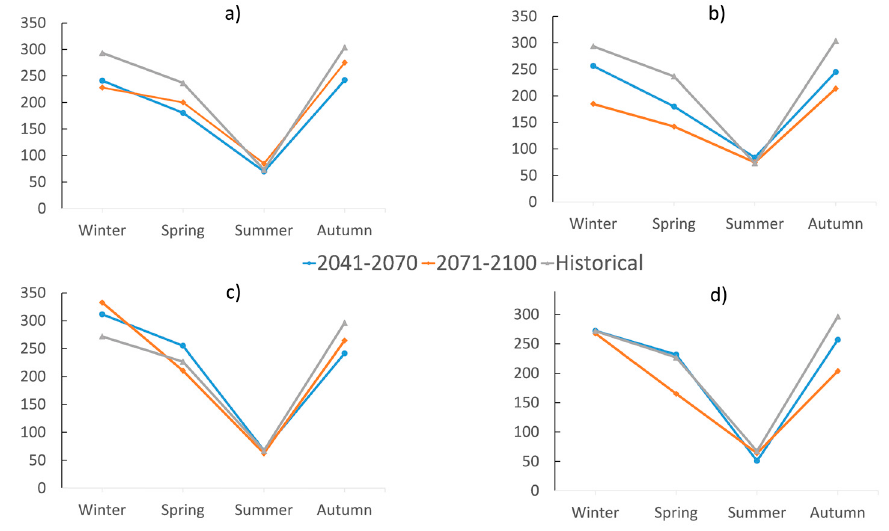
Figure 4. Seasonal precipitation change (mm) in ( a ) RCA4_CNRM-CM5 (RCP 4.5); ( b ) RCA4_CNRM-CM5 (RCP 8.5); ( c ) RCA4_EC-EARTH (RCP 4.5); and ( d ) RCA4_EC-EARTH (RCP 8.5).